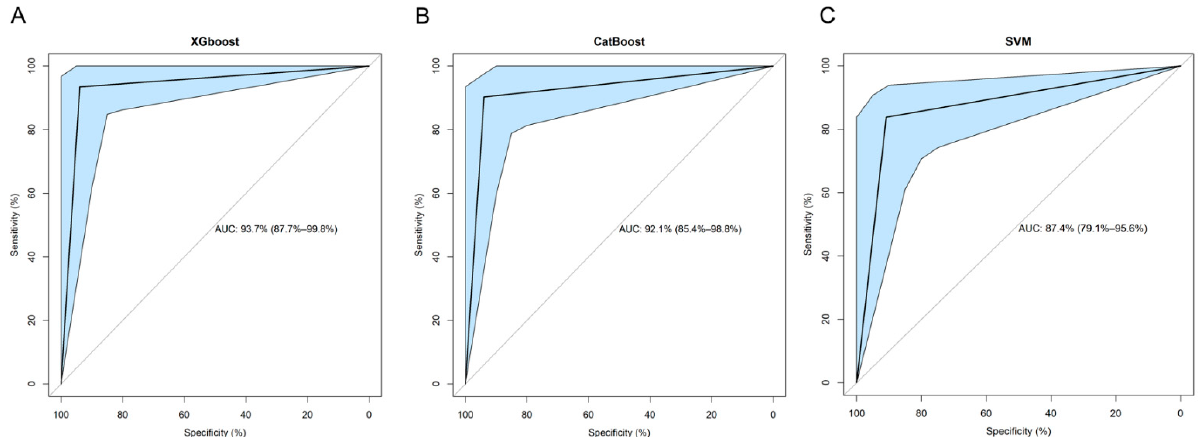
Figure 4. Receiver operating characteristic (ROC) curves of machine learning models. XGboost ( A ), CatBoost ( B ) and support vector machine (SVM) ( C ). Light blue areas represent the respective 95% confidence intervals calculated with bootstrapping. AUC: Area Under the Curve. Table 2. Performance of the three machine learning algorithms.